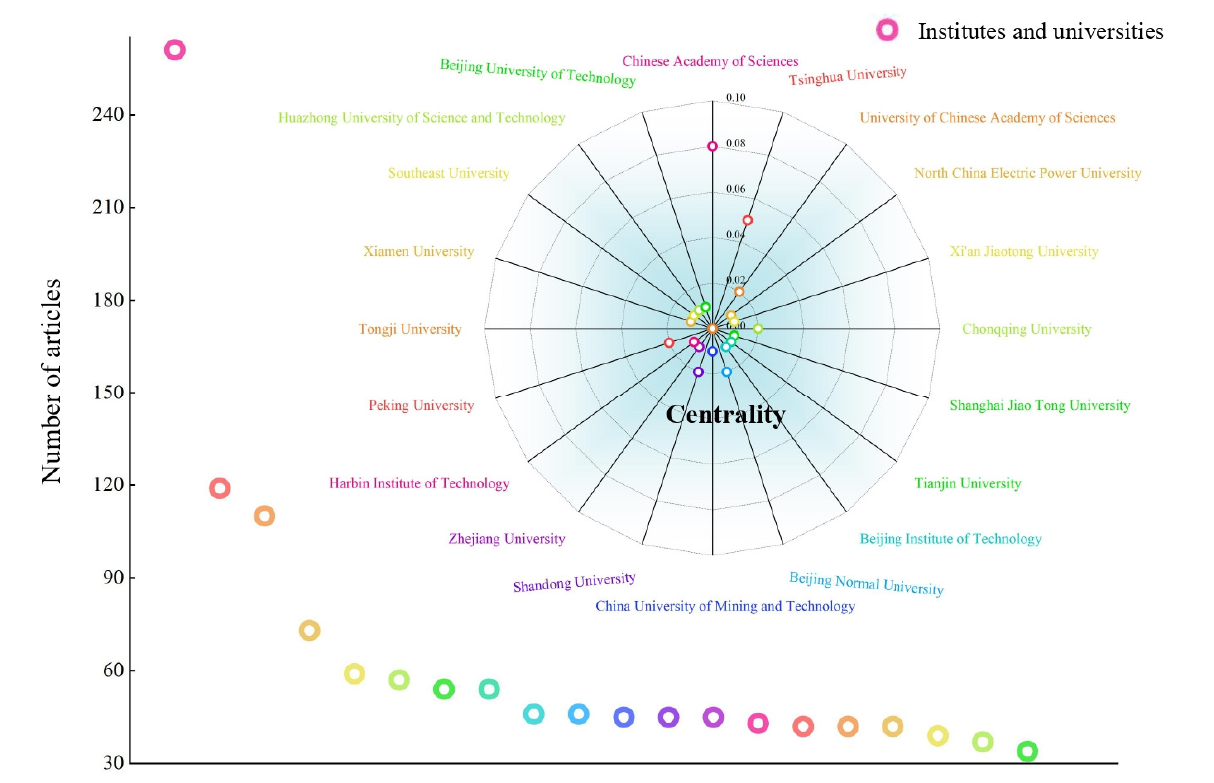
Figure 6. Top 20 institutes and universities.